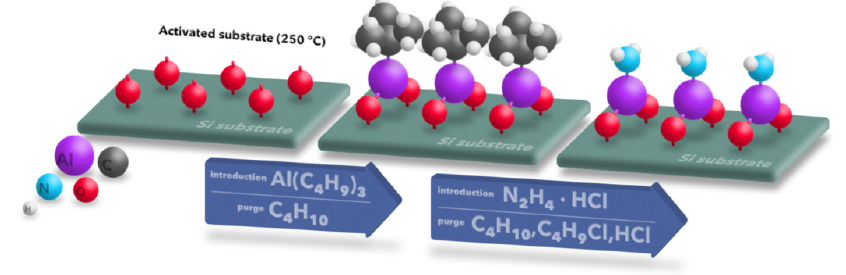
Figure 3. The scheme of an ideal ALD process.